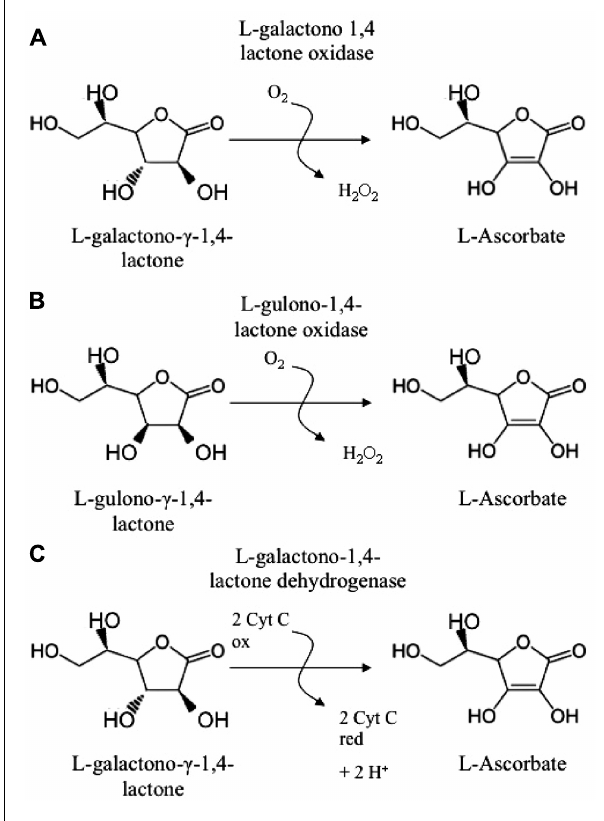
FIGURE 1 | Last enzymes inASC biosynthetic pathways. (A) Pathway in protists and fungi; (B) Animal pathway; (C) Main pathway in higher plants.